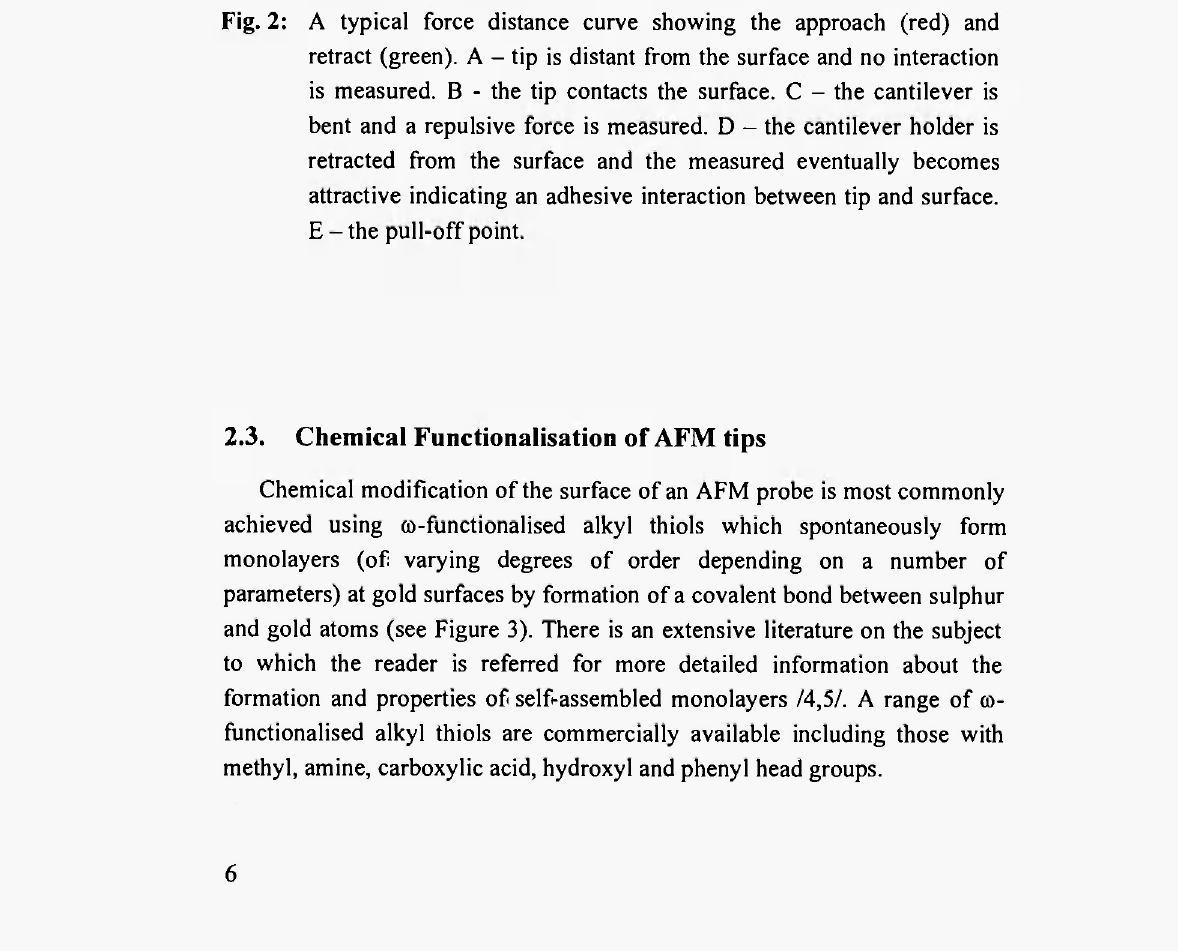
Fig. 2: A typical force distance curve showing the approach (red) and retract (green). A - tip is distant from the surface and no interaction is measured. Β - the tip contacts the surface. C - the cantilever is bent and a repulsive force is measured. D - the cantilever holder is retracted from the surface and the measured eventually becomes attractive indicating an adhesive interaction between tip and surface. Ε - the pull-off